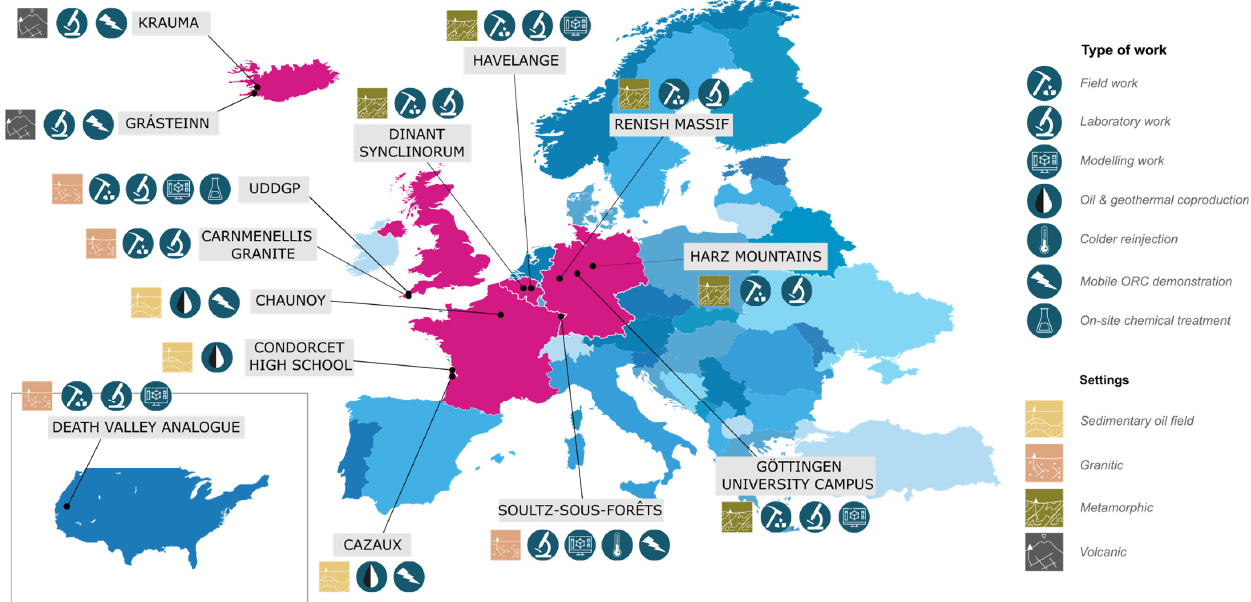
Figure 2. Location map of the sites and type of works performed in the MEET project. Various geological settings are represented: volcanic areas (Krauma and Grásteinn), sedimentary basins (Chaunoy, Condorcet High School and Cazaux), granitic basements (Soultz-sous-Forêts; UDDGP; Death Valley analogue) and metamorphic basements (Have- lange, Göttingen University campus, Harz Mountains and Rhenish Massif